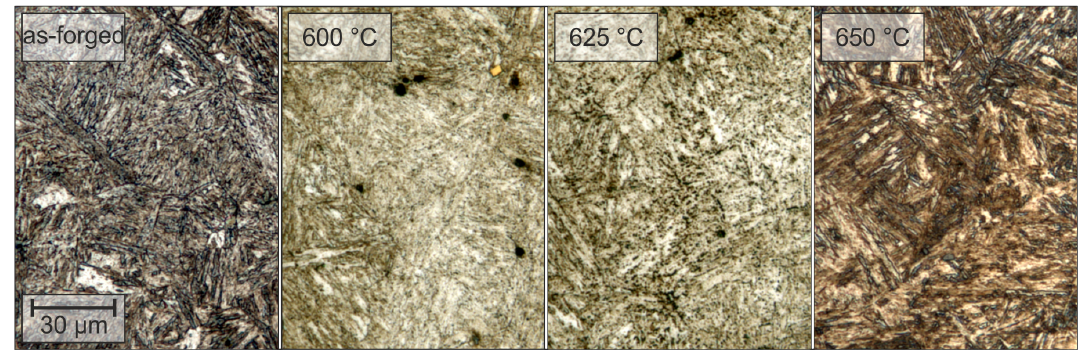
Figure 5. Microstructure observable with light optical microstructure (LOM) for the as-forged state and the at 600 ◦ C, 650 ◦ C and 675 ◦ C annealed samples. Exemplary alloy L2 is shown in this